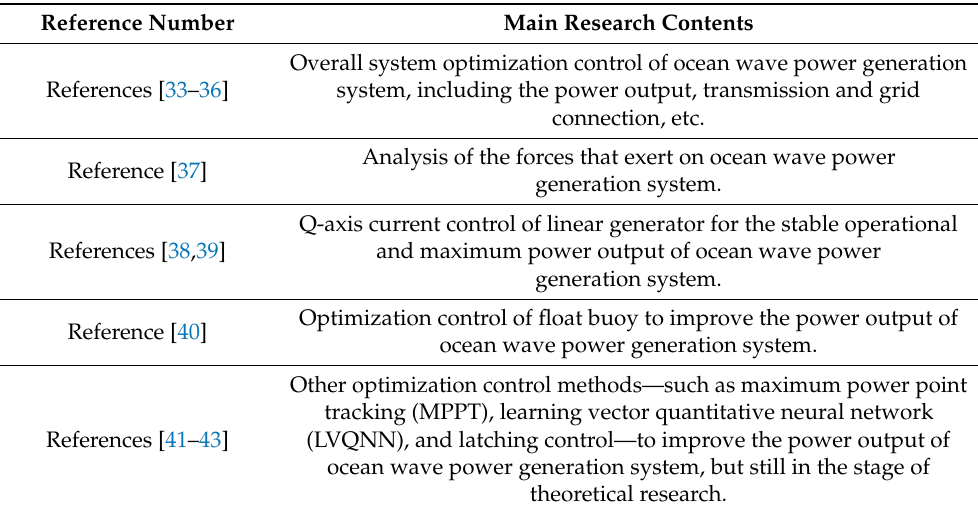
Table 2. Optimization control classification of reference papers [33–43] for ocean wave power generation